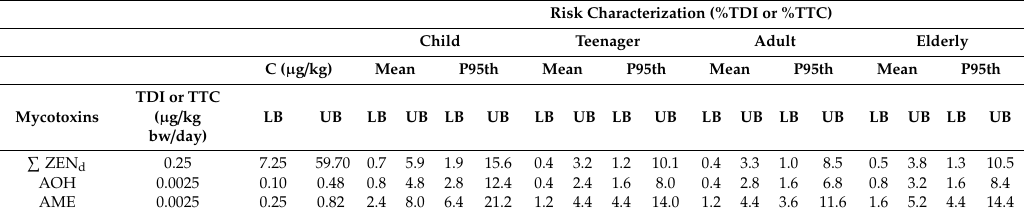
Table 5. Risk characterization of detected mycotoxins in di ff erent population groups based on the percentage of tolerable daily intake considering four di ff erent scenarios per group: Mean and 95th percentile consumption value combined with lower and upper bound of contamination. Risk Characterization (%TDI or